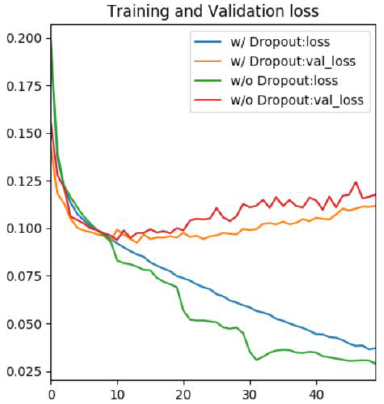
Figure 14. Transitions of training and validation losses with and without dropout (k = 10.0, with RAdam as optimizer and without data augmentation).